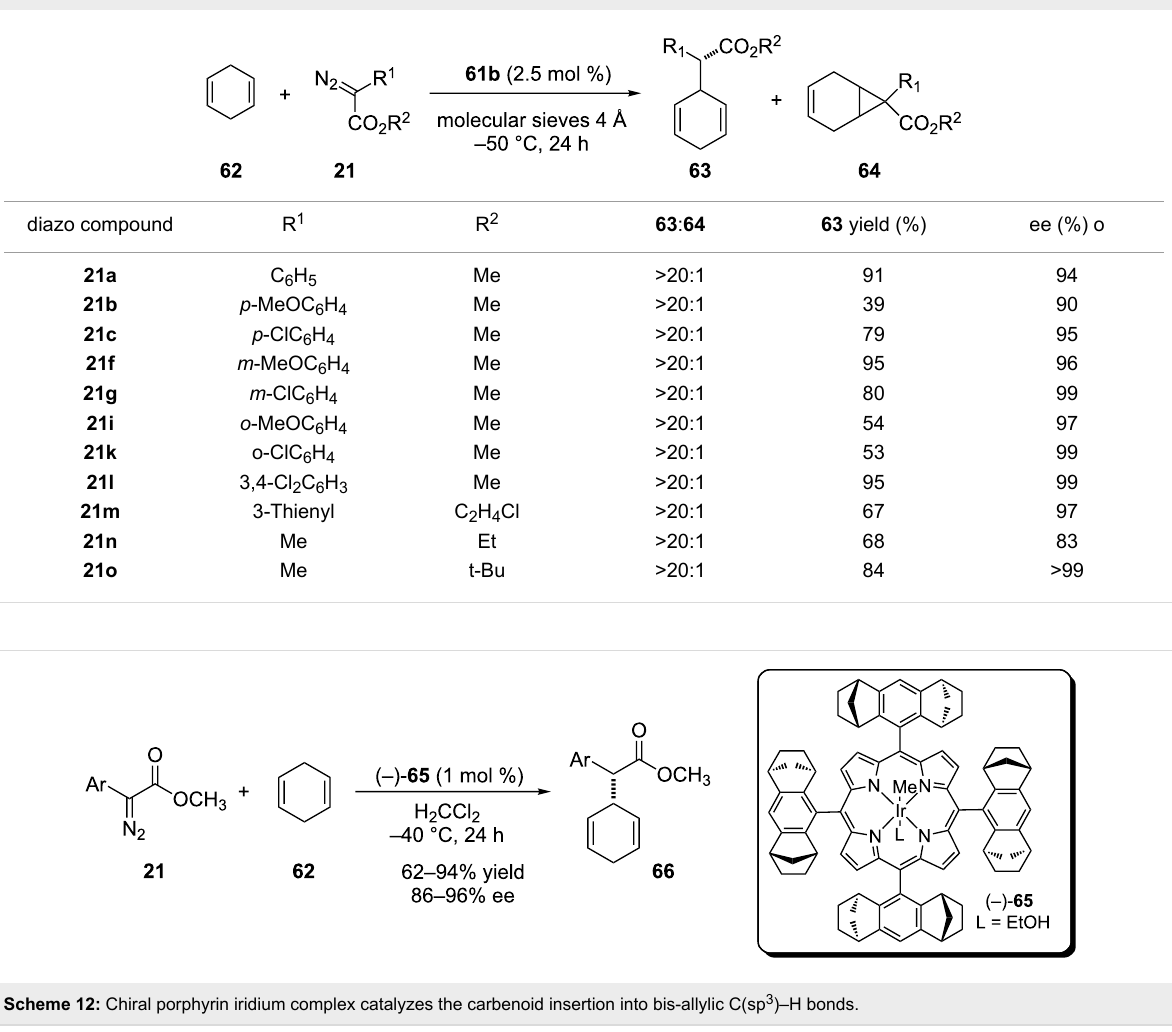
Table 9: Intermolecular insertion of chiral iridium carbenoids into the 1,4-cyclohexadiene ( 62 ) bis-allylic C(sp 3 )–H bond.